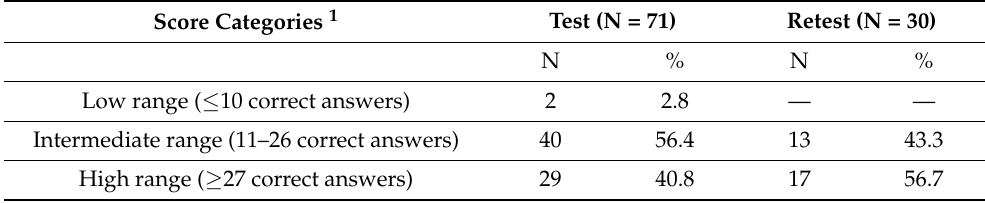
Table 2. Score categories: Test vs. Retest.